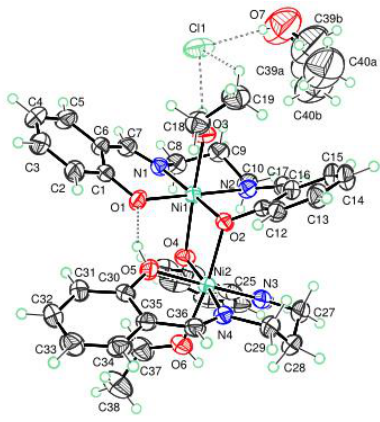
Figure 2. Plot of the [Ni 2 HL 2 (EtOH) 2 ](Cl)(EtOH) molecule with the atom-labelling scheme. Displace- ment ellipsoids are drawn at the 50% probability level. H atoms are represented as small circles.